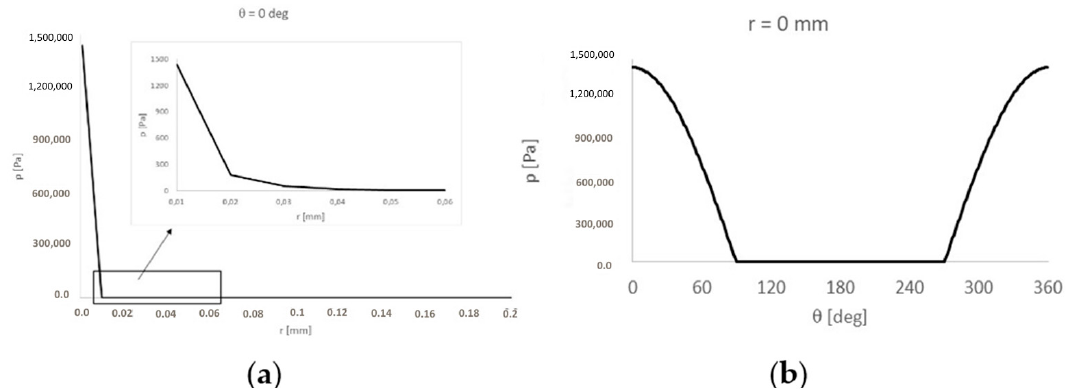
Figure 27. ( a ) Course of hydrodynamic pressure p ( r , θ ) versus radius r of projection of the hemisphere on mating plane, for θ = 0 deg; ( b ) Course of hydrodynamic pressure p ( r , θ ) versus angle θ for r = 0 mm.